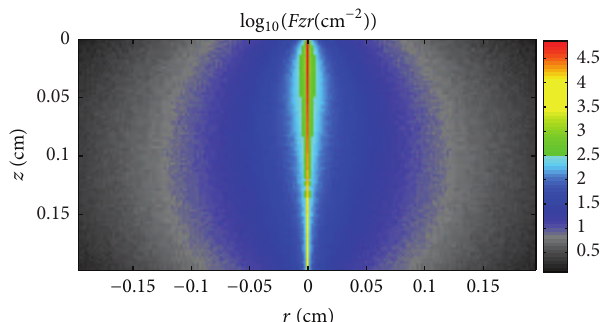
Figure 7: Light propagation in the thermotropic material at 36 ∘ C at the wavelength of 500 nm.